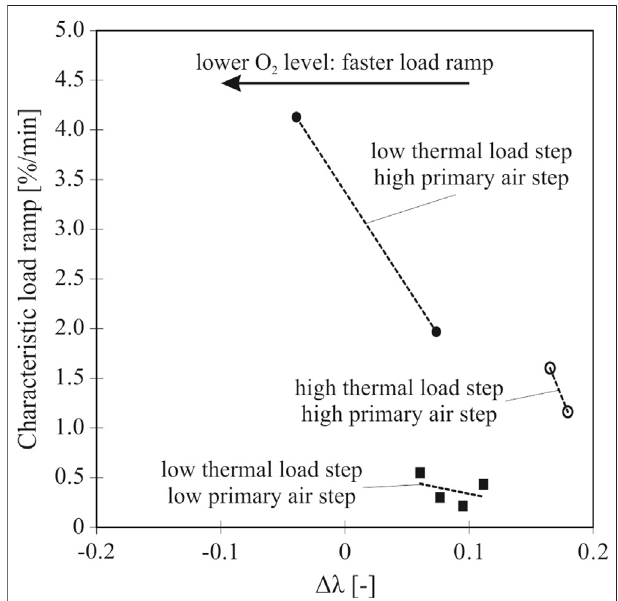
FIGURE 10 | In fl uence of the excess air factor on the characteristic load ramp during load